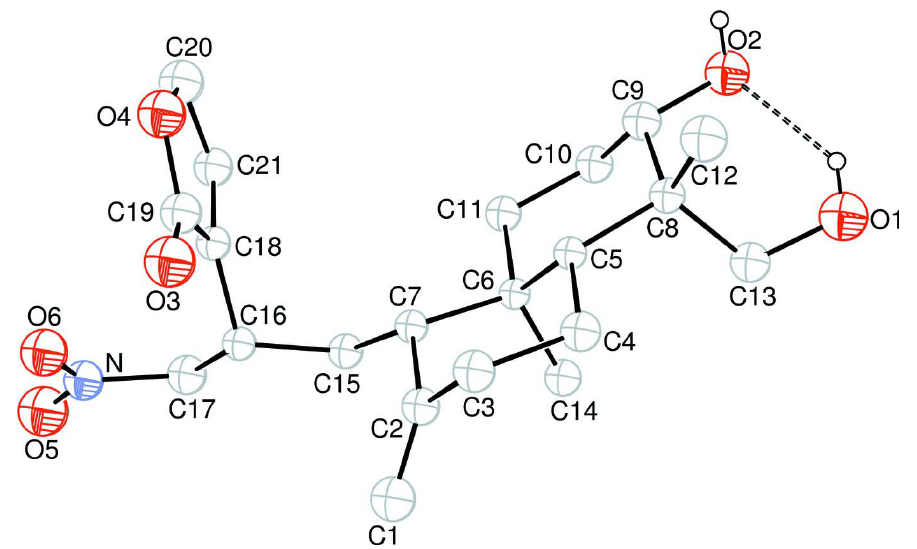
Figure 1 The molecular structure of the title molecule, with the atom-numbering scheme. Hydrogen bond is shown as dashed line.